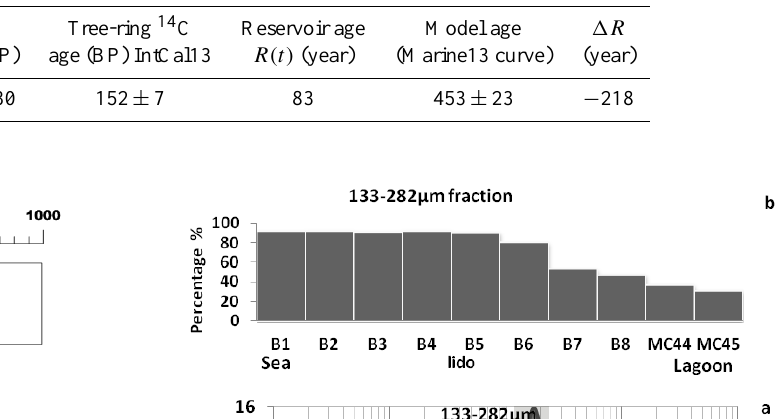
Table 2. 14 C date of modern pre-bomb shell samples in MC45 core and its reservoir ages. Estimation of R(t) and (cid:49)R were estimated using the 210 Pb ex date.